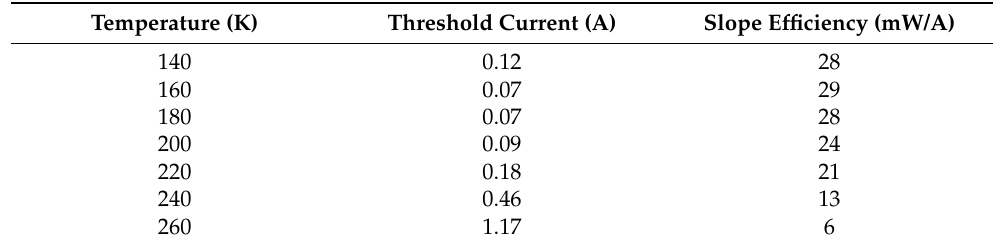
Table 1. Temperature dependence of the PCSEL threshold current and slope efficiency.